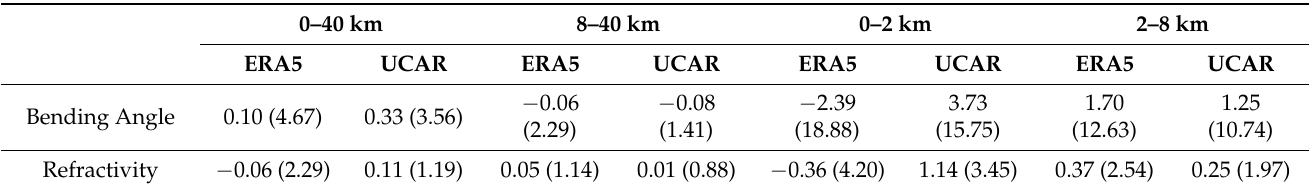
Table 3. Bending angle and refractivity fractional difference mean and standard deviation between STAR retrievals with ERA-5 and UCAR retrievals. The standard deviations are given in parenthesis.